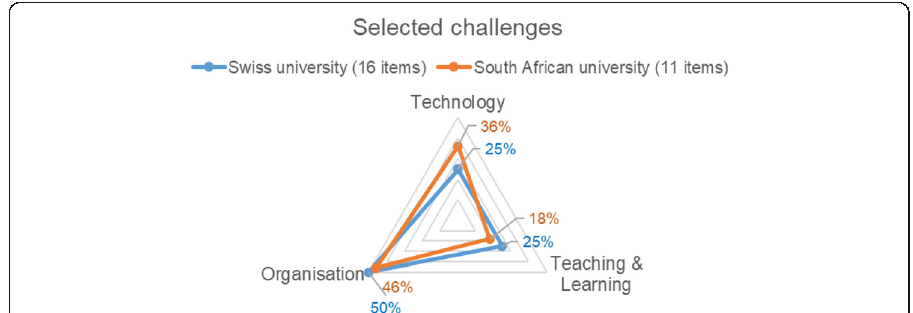
Fig. 4 Percentage of the selected challenges of adaptive learning for the ranking round across dimensions for each